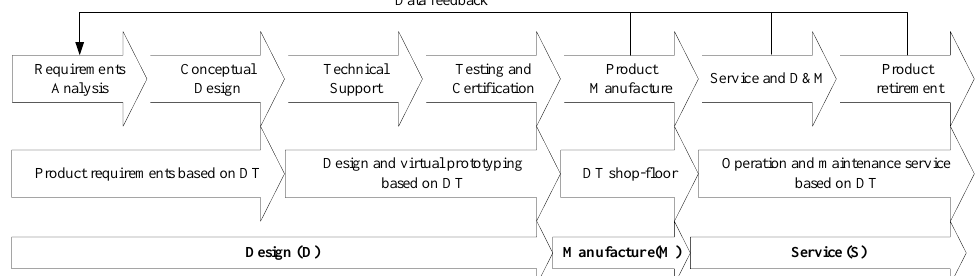
Figure 4. The decomposition form of the DMS-DT integration framework.